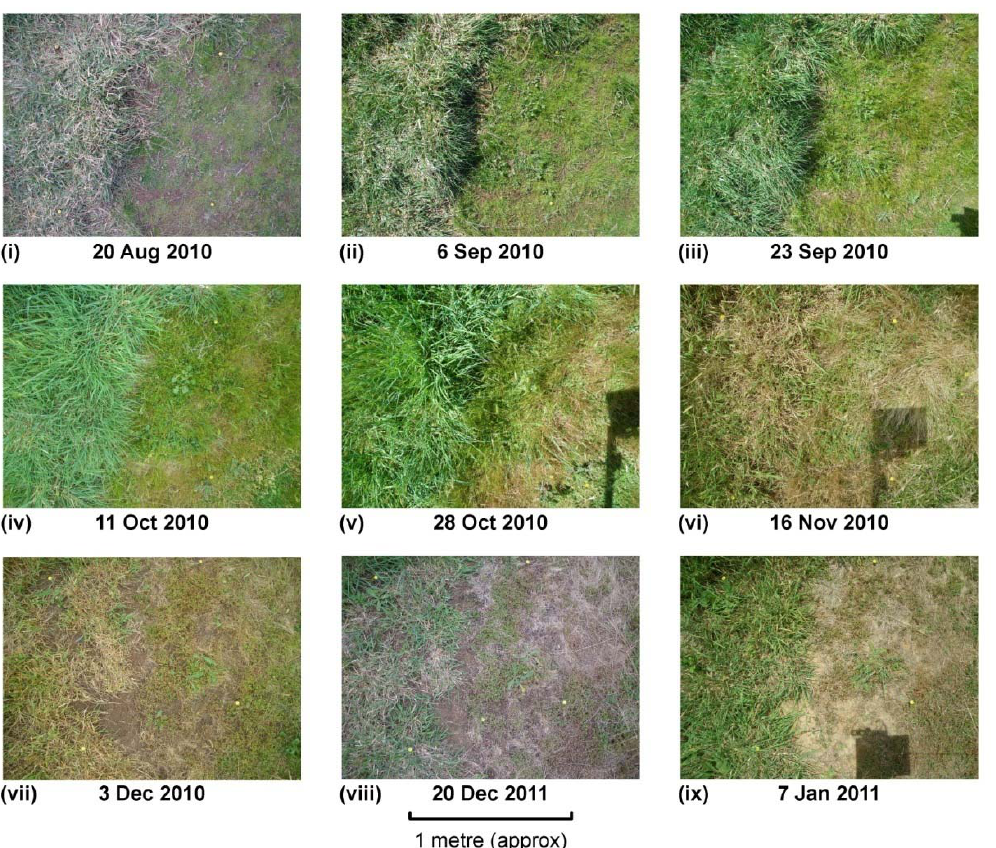
Figure 4. Time-series of images from the RGB digital camera mounted on one of the nodes at the Crace site. Shadows from the node arm can be seen in iii, v, vi, and ix. The 20 mm diameter yellow markers used as GCPs for rectifying images are visible as white dots, but are obscured by grass in some